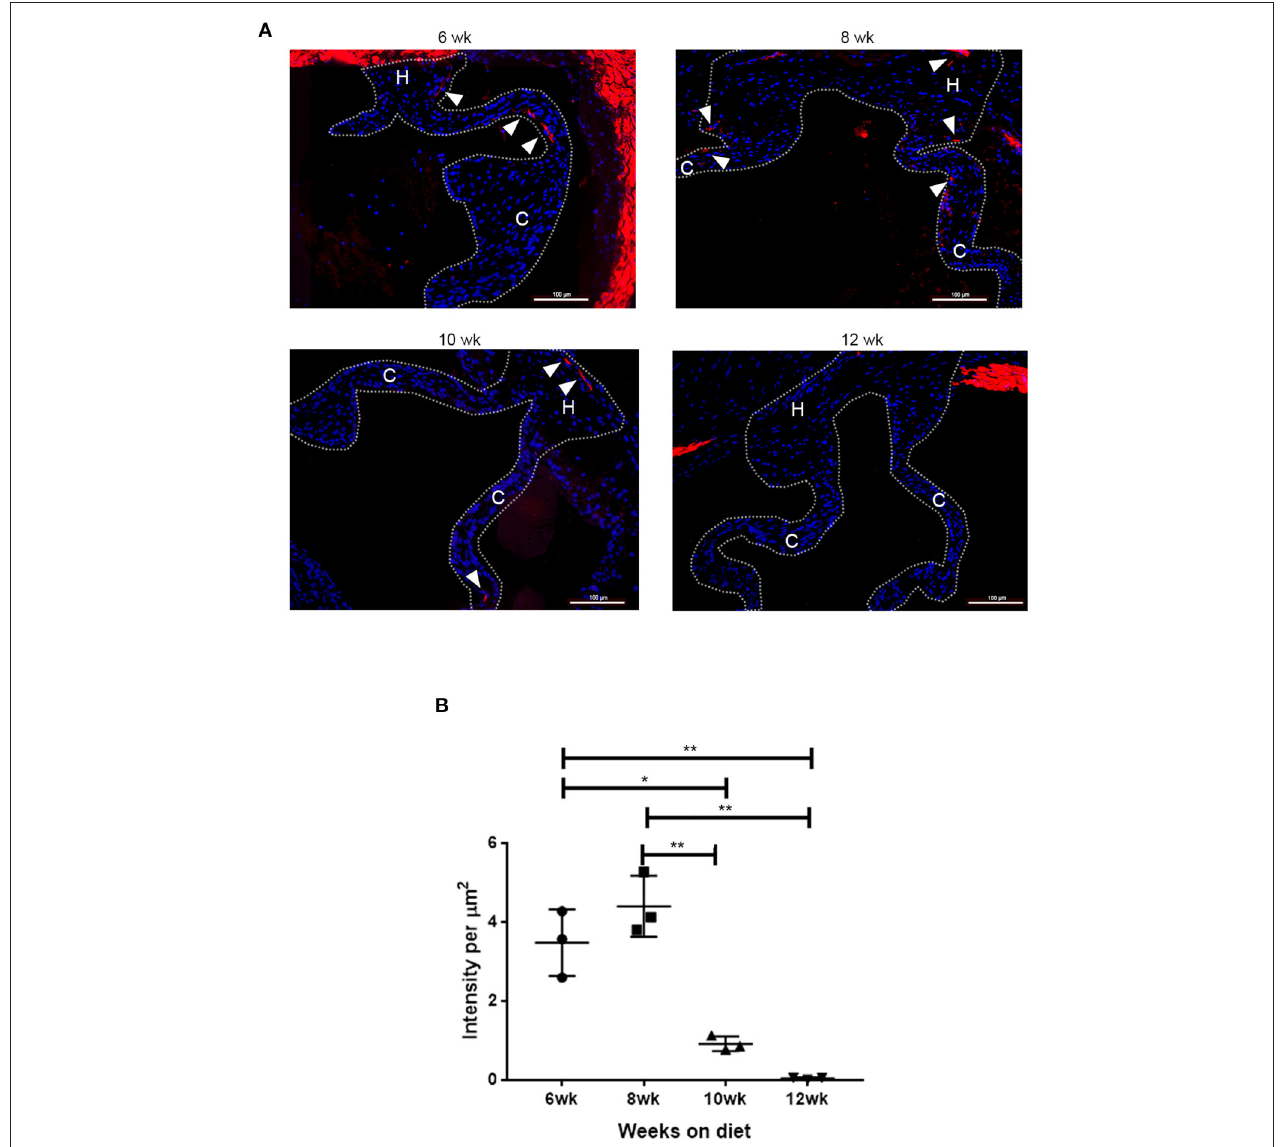
FIGURE 3 | Time course of de novo smooth muscle α -actin (SMA) expression in disease aortic valves. (A) Aortic valve sections from LDLr − / − ApoB 100 mice on the T2DM diet labeled for SMA (red) and 6-diamidino-2-phenylindole (DAPI) (blue). Cusp and hinge regions are outlined with dashed lines. The SMA expression is observed in the valve leaflets in sections from 6 weeks through 10 weeks of the T2DM diet mice (white arrowheads). (B) Quantification of fluorescence intensity in SMA labeled sections from LDLr − / − ApoB 100 mice on the T2DM diet for 6–12 weeks ( n = 3 per time point). Differences between groups were analyzed by one-way ANOVA with Bonferroni’s correction. * p < 0.05, ** p < 0.005.